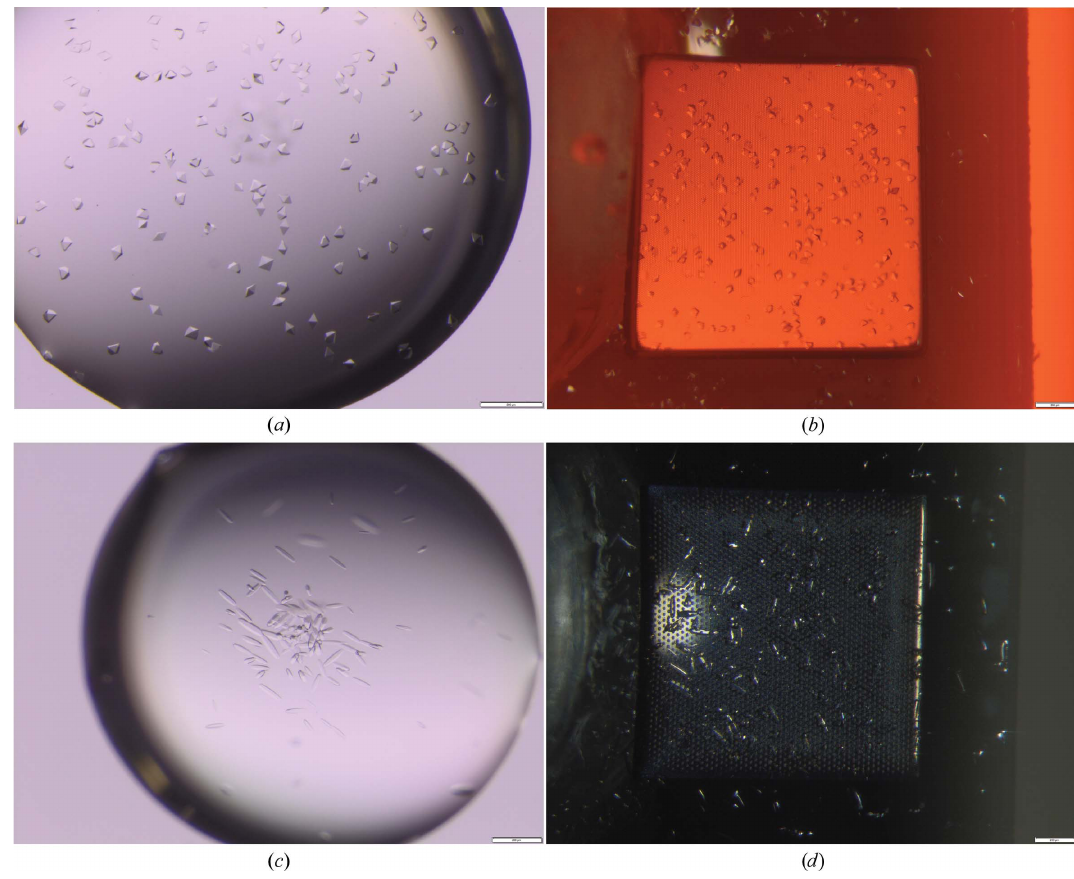
Figure 6 Exemplary results of crystallization experiments for proteinase K ( a , b ) and thermolysin ( c , d ) using the same crystallization conditions for conventional hanging-drop crystallization ( a , c ) and on-chip crystallization on Roadrunner I chips ( b , d ). The proteinase K crystals are around 30 m m in size and appeared overnight. The thermolysin crystals needed 1–2 days to reach a maximal size of (cid:4) 35 (cid:3) 150 m m. The scale bars at the bottom right corners each have a length of 200 m m. The different background colors in the pictures showing on-chip crystallization stem from the different polylactic acid colors used for 3D-printing of the crystallization